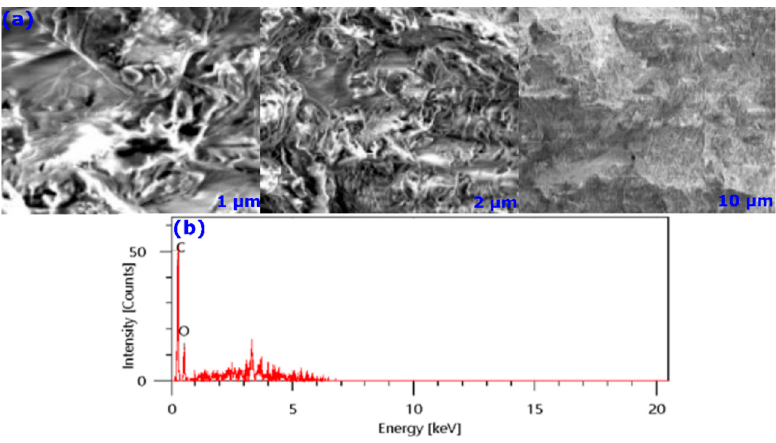
Figure 3. SEM ( a ) and EDS ( b ) analyses of AS.